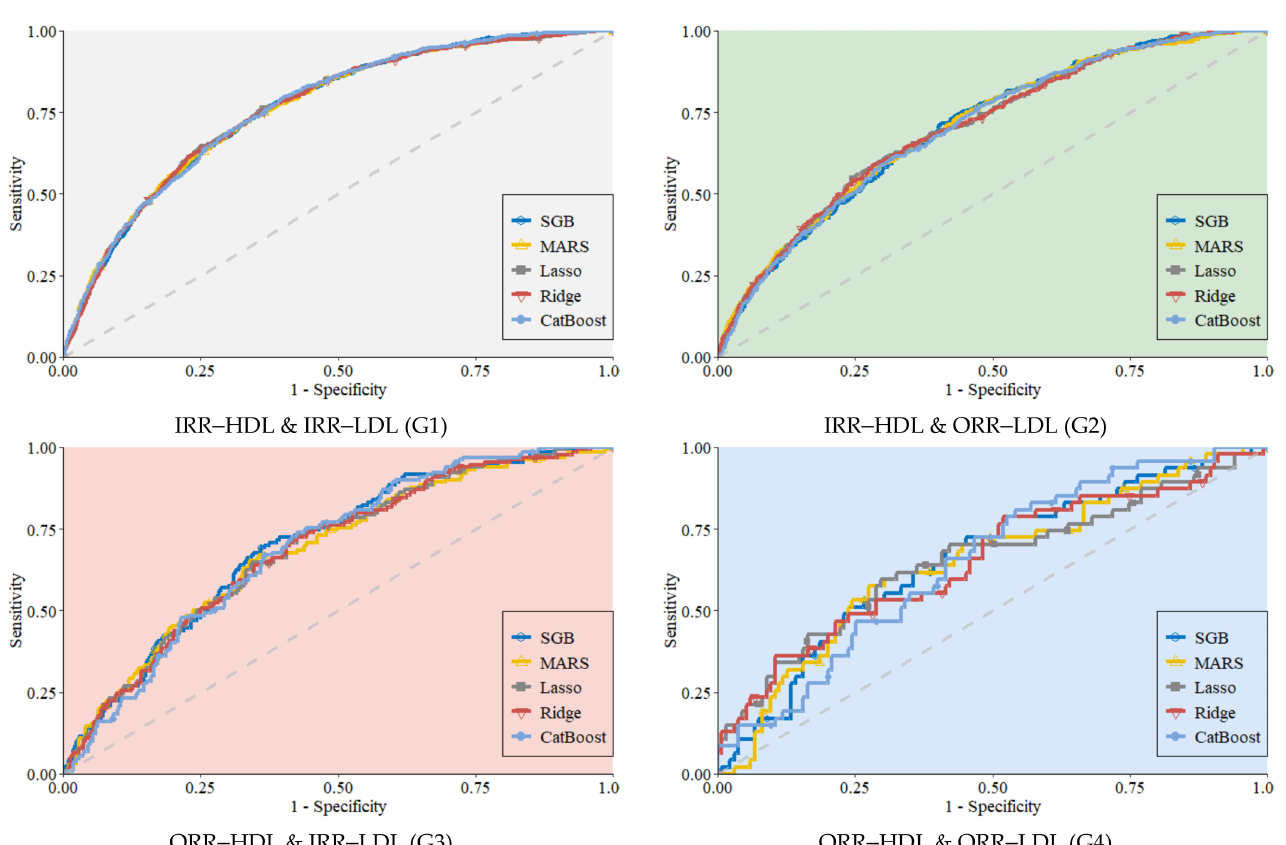
Figure 3. ROC curves of the five algorithms for each